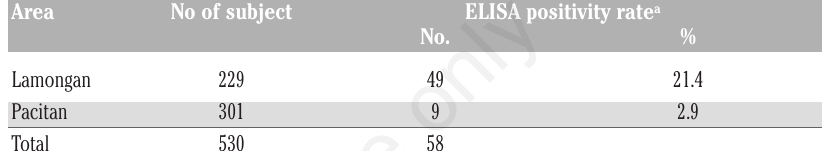
Table 2. PCR positivity rate among healthy school children by geographic area